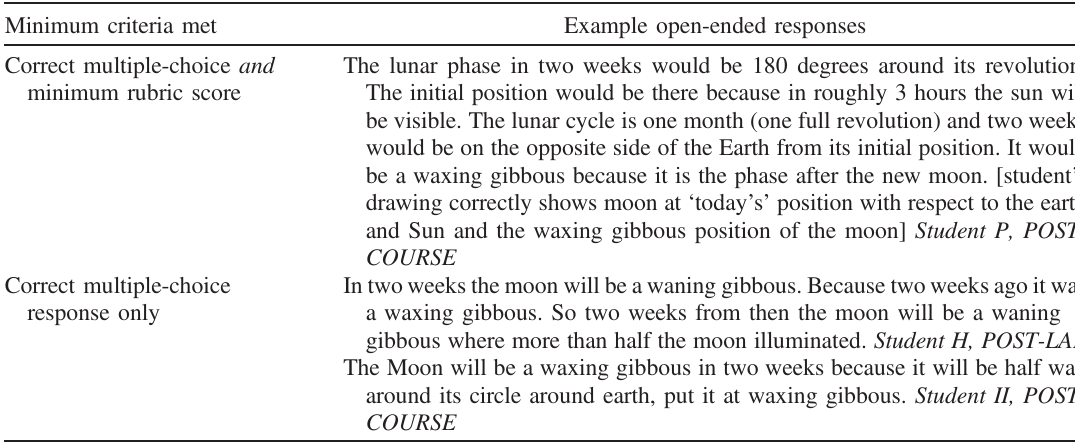
TABLE IX. Example open-ended responses given for the assessment asking students to predict the phase of the Moon two weeks from the current time and Moon